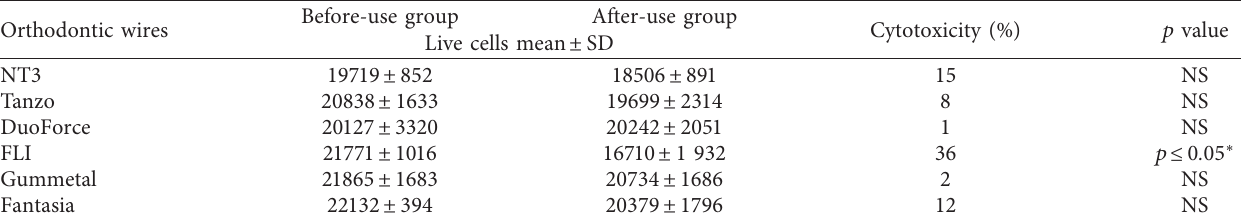
Gummetal 21865 ± 1683 Fantasia 22132 ± 394 20379 ±